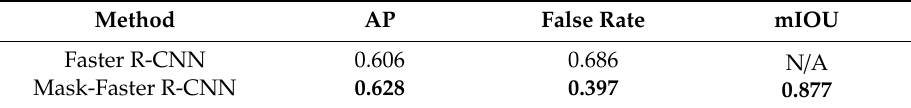
Table 4. Comparison of the Mask-Faster R-CNN and Faster